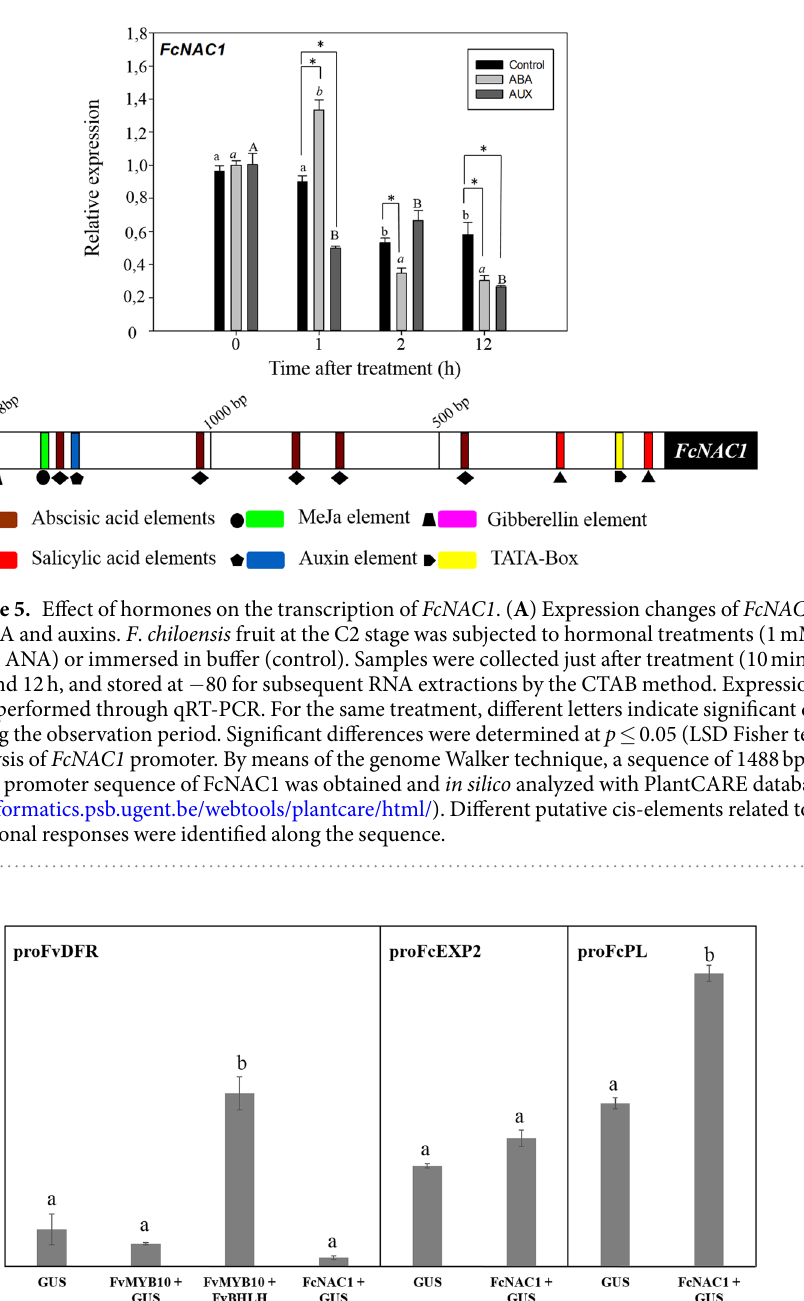
and FcNAC1 transcription factor (Fig. 7E).